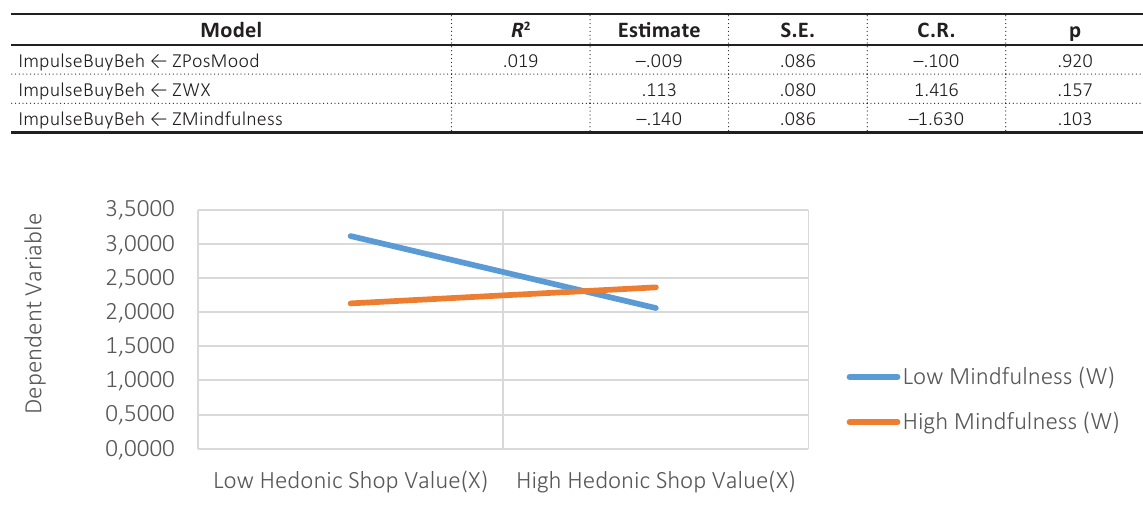
Table 10. The regression weight results of the moderator role of positive